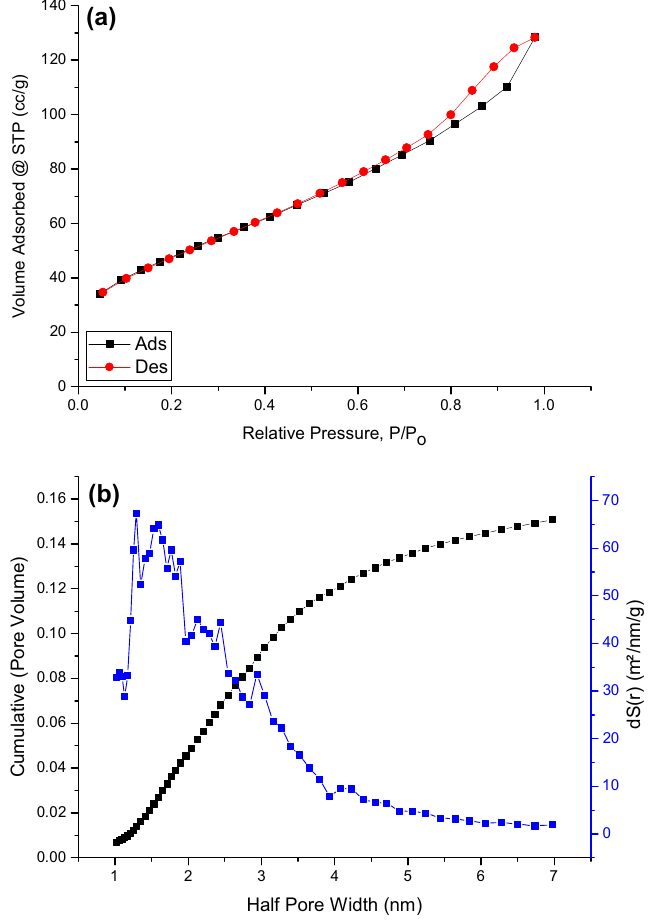
Figure 3. Nitrogen physisorption isotherm and DFT method of fabricated mesoporous γ-Al 2 O 3